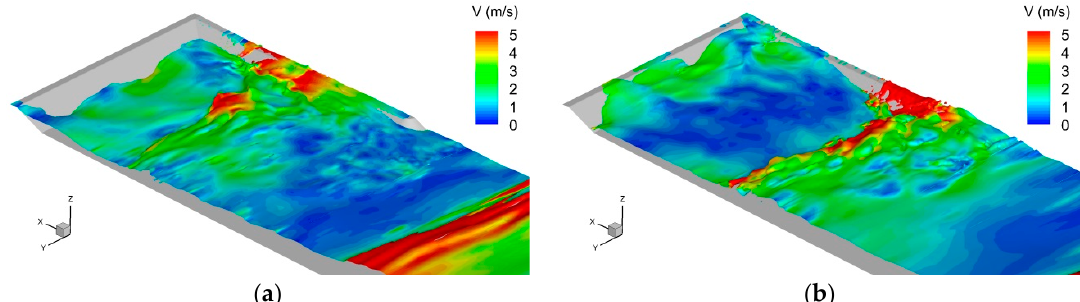
Figure 23. Free surface obtained with FLUENT for the moment when: ( a ) wave run-down the dike; ( b ) wave overtops the groin (free surface is coloured by velocity magnitude).